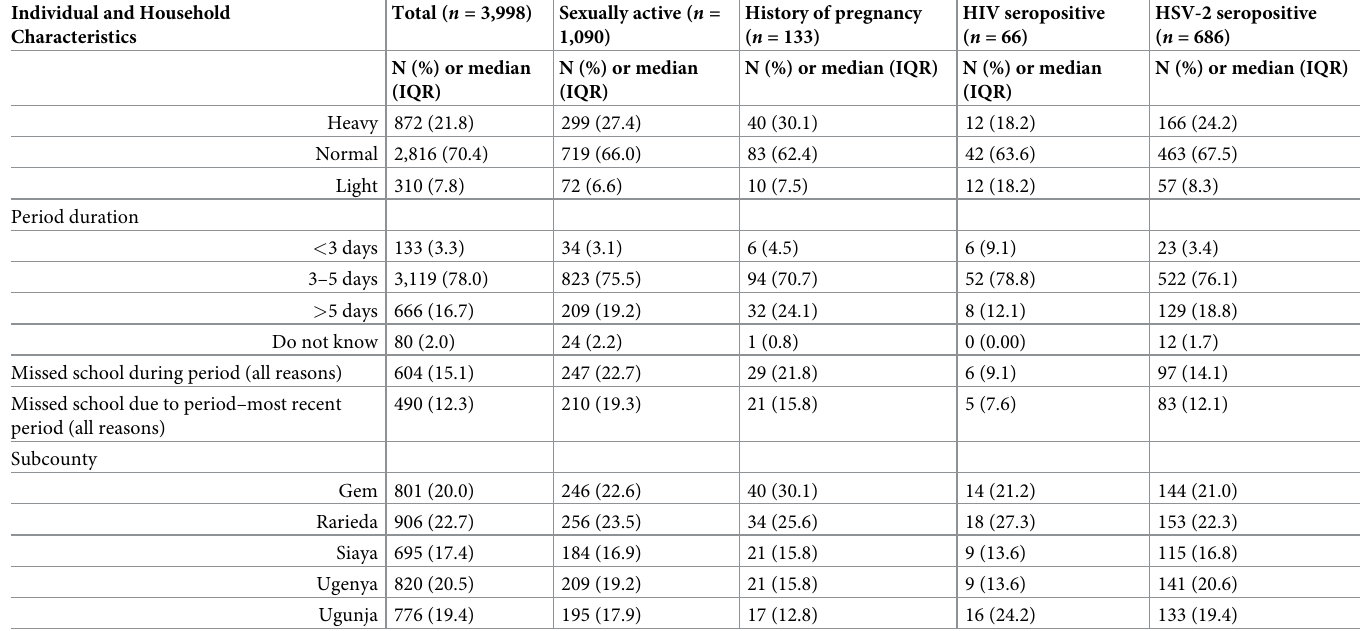
Sociodemographic and individual